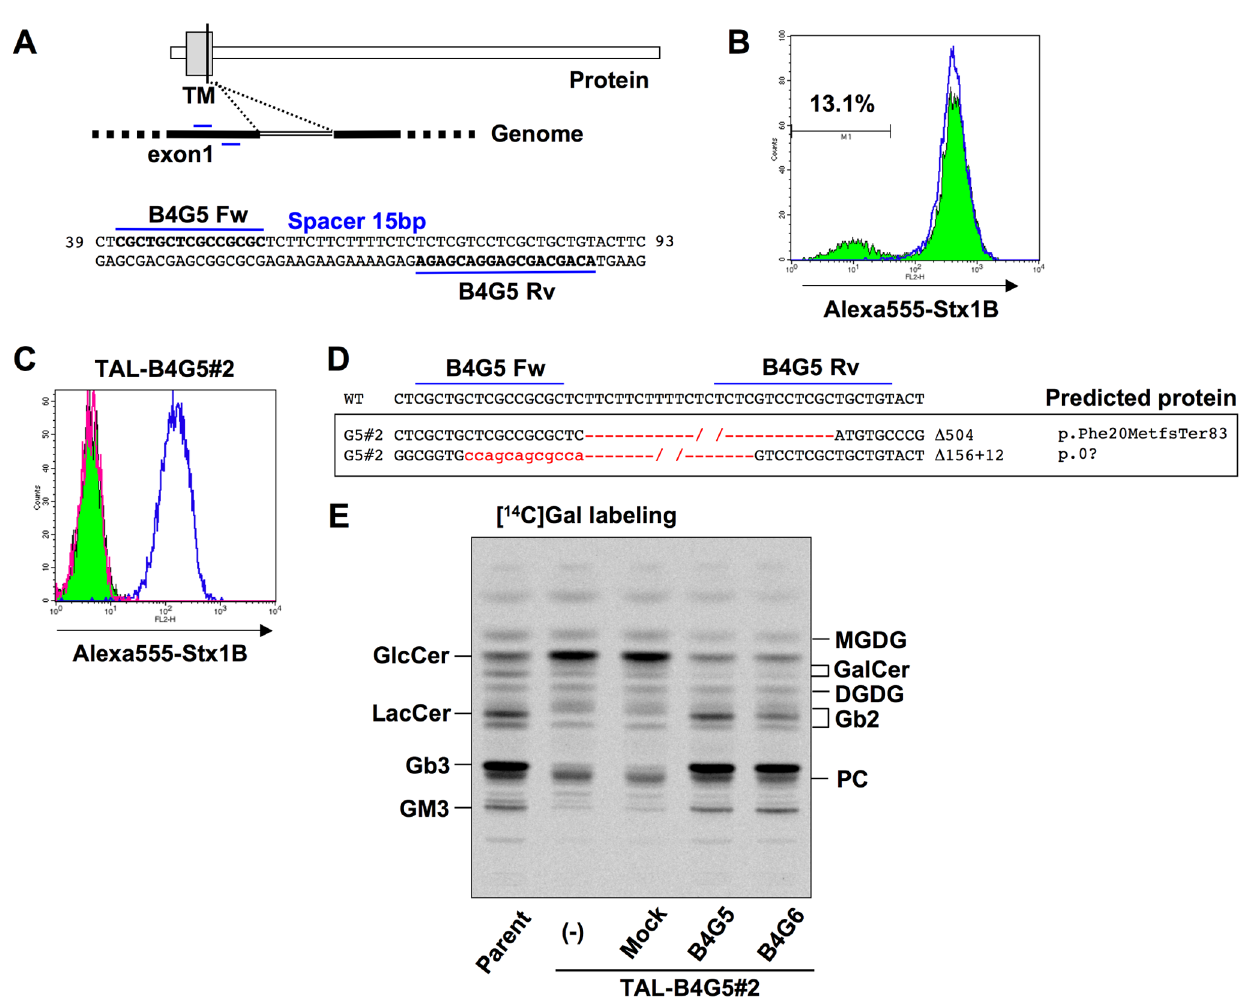
Figure 6. Isolation of a B4GalT5 -deficient clone. A, Target sites of TALEN-B4G5 pair (TAL-ModA-B4GalT5) in human B4GalT5 gene. The sequences are located in exon 1, which codes part of the transmembrane domain. The target sites are shown in bold. The numbers on the right and left of the sequence indicate the sequence numbers from the A of the translation initiation codon, based on B4GalT5 mRNA (accession number AB004550). B, Surface expression of StxRs on TALEN-B4GalT5–treated HeLa cells. HeLa cells were treated with TALEN-B4GalT5 (colored histogram with black line) or empty vectors (blue line), and the cells were stained with Alexa-555-Stx1B. C, Surface expression of StxRs on a TAL-B4GalT5 clone (TAL-B4G5 # 2). TAL- B4G5 # 2 cells were stained with Alexa-555-Stx1 B (colored histogram with black line) or not (magenta line) and HeLa-mCAT # 8 cells were stained with Alexa-555-Stx1 B (blue line). D, Indel analysis of B4GalT5 gene in TAL-B4G5 clone (TAL-B4G5 # 2). The deletion is shown in red and its length specified on the right of the sequence. The predicted proteins are indicated based on the recommended description (see Materials and Methods) [50]. E, Metabolic labeling of lipids with radioactive galactose. TAL-B4G5 # 2 clone and B4GalT5- or B4GalT6-restored TAL-B4G5 # 2 cells obtained by retroviral vector–mediated overexpression were labeled with [ 14 C]galactose for 16 h, and lipids extracted from the cells were separated by HPTLC. Radioactive image of an analyzed TLC plate is shown.